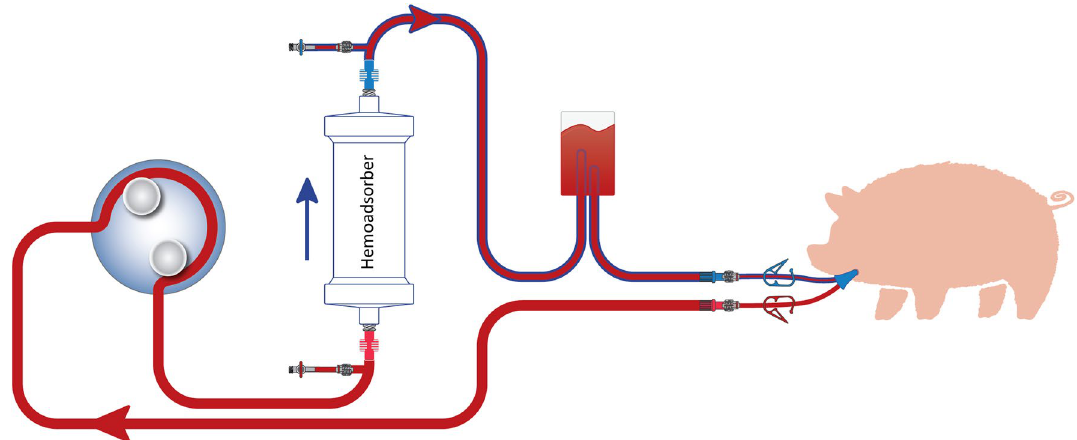
Figure 1. Extra-corporeal circuit. According to study protocol, 1 h following anti-infective administration, study animals were randomly allocated to either CytoSorb hemoadsorption or sham procedure on a 1:1 basis. For animals allocated to the sham procedure, a similar circuit without hemoadsorber was